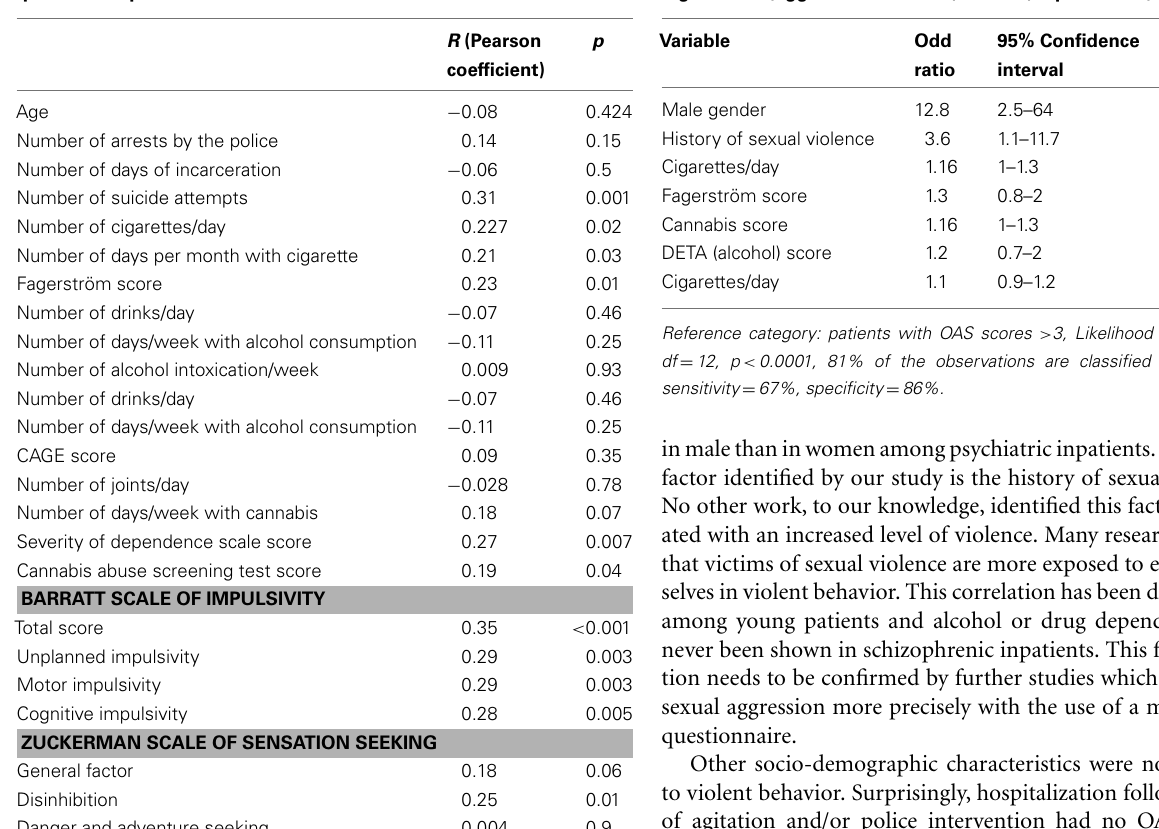
Table 4 | Multinomial logistic regression among patients presenting higher OAS (aggressive behavior) scores (Superior to